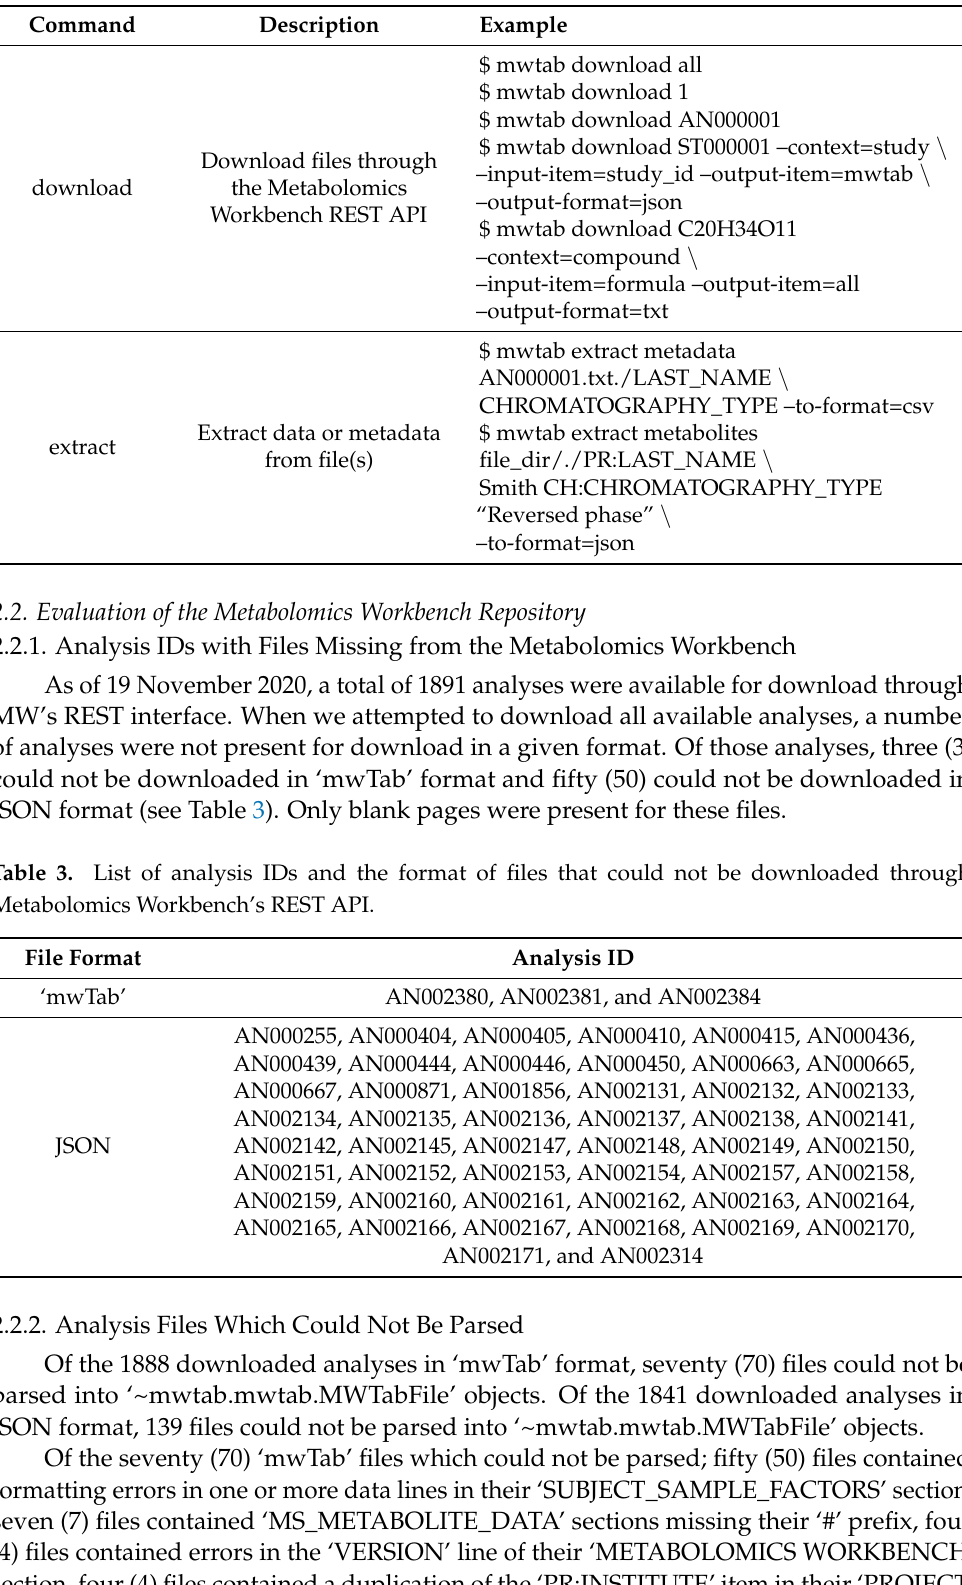
Table 2. Command patterns for using the ‘mwtab’ as a Command-Line Interface.